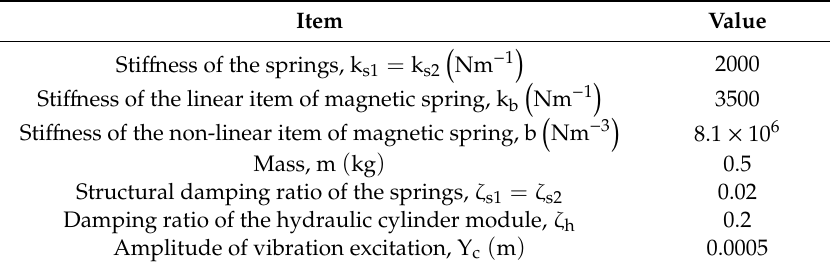
Table 1. Default parameters for simulation.